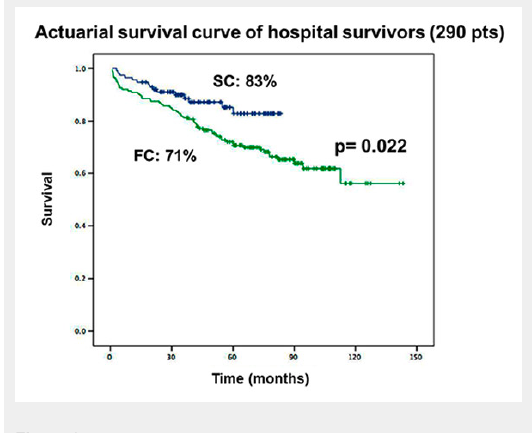
Actuarial survival of hospital survivors (290 patients); SC: blue; FC: